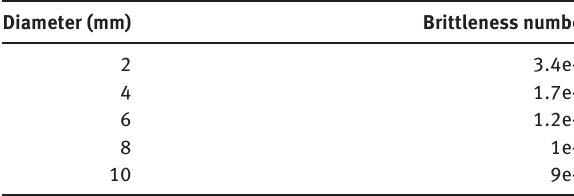
laminates open hole. 2s